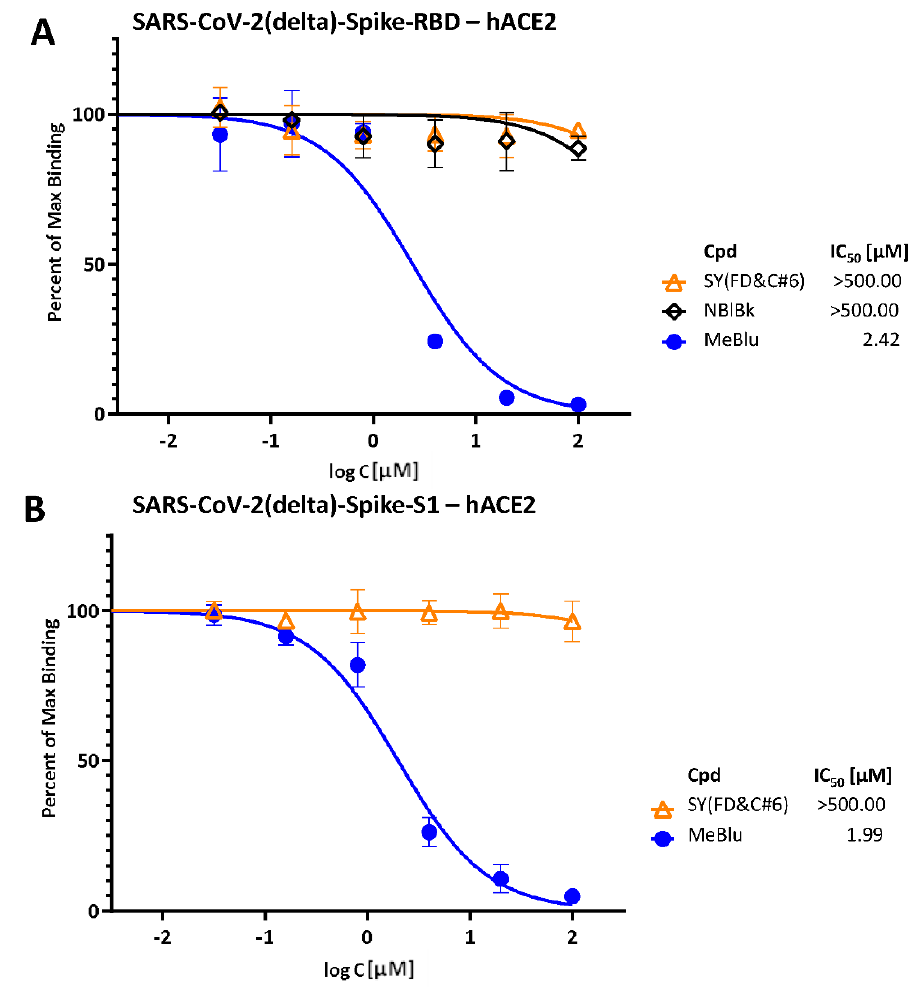
Figure 2. Concentration-dependent inhibition of SARS-CoV-2 delta (B.1.617.2) spike RBD ( A ) and S1 protein ( B ) binding to hACE2 by MeBlu. Concentration–response curves obtained in a similar setup as in Figure 1 but with the spike protein RBD ( A ) and S1 ( B ) of the delta (B.1.617.2) variant in the presence of increasing concentrations of test compounds. Data (mean ± SD) were normalized and fitted with standard inhibition curves; obtained IC 50 values are shown on the right for each figure.